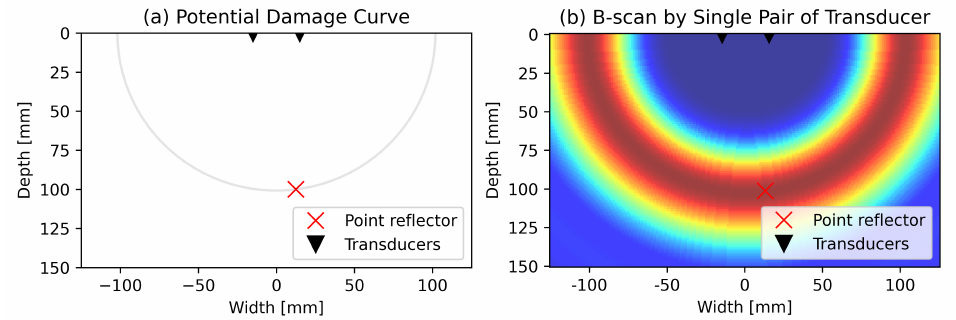
Figure 4. ( a ) Potential damage curve and ( b ) corresponding B-scan for a single pair of transducers.